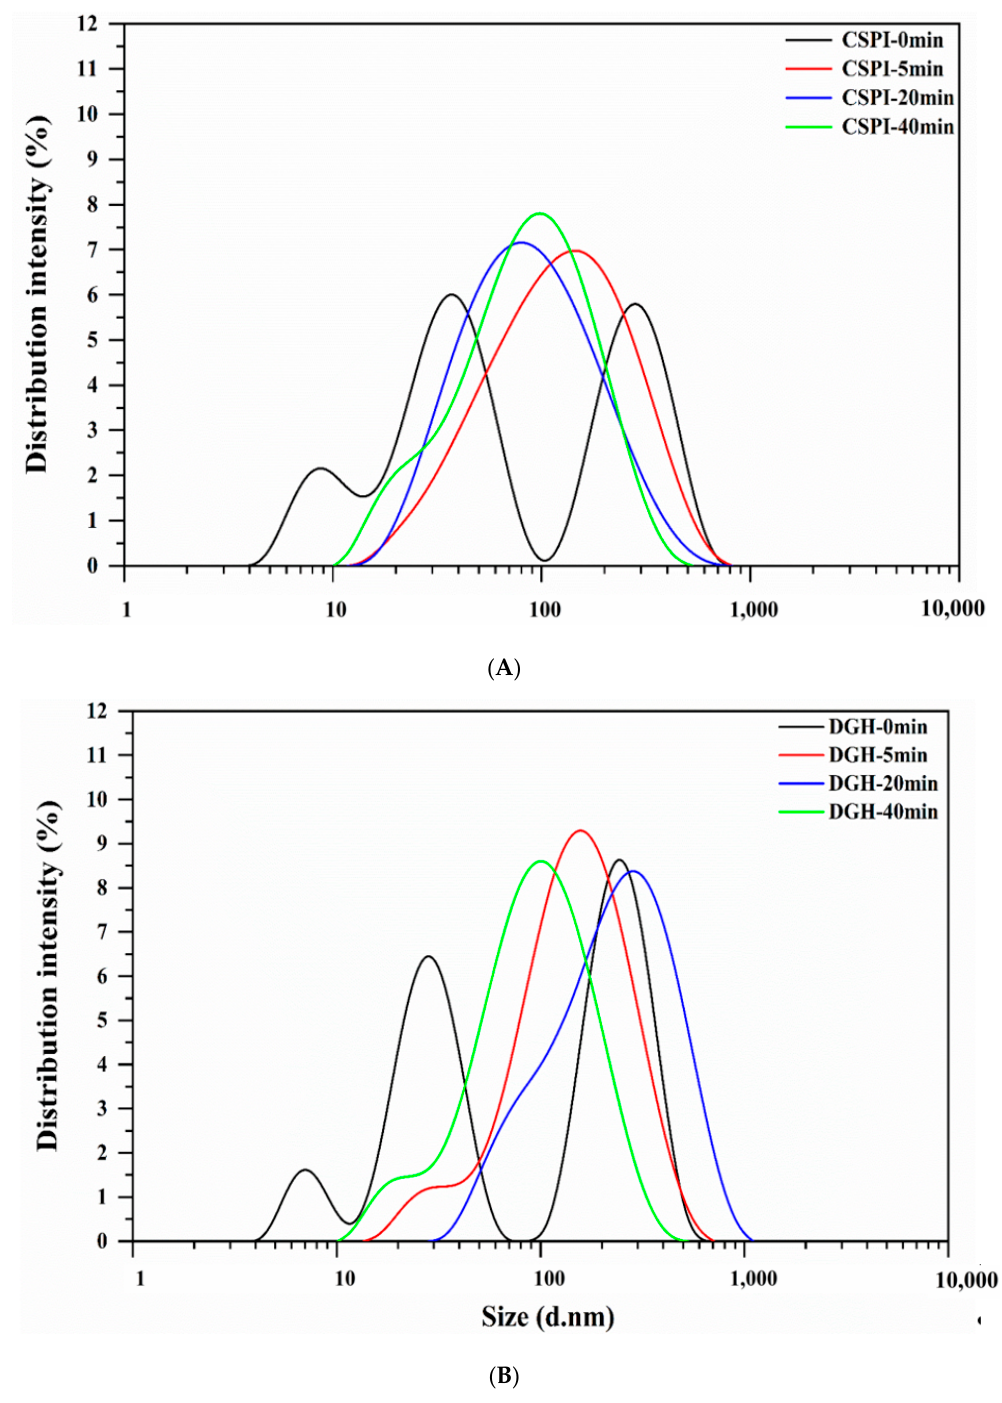
Figure 3. Effect of high-intensity ultrasound treatment (20 kHz at 400 W for 0, 5, 20, 40 min) on the particle size distribution of CSPI ( A ) and DGH ( B ).